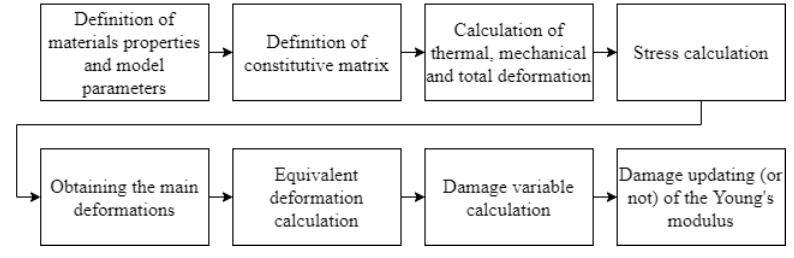
Figure 9. Flowchart 3: UMAT subroutine